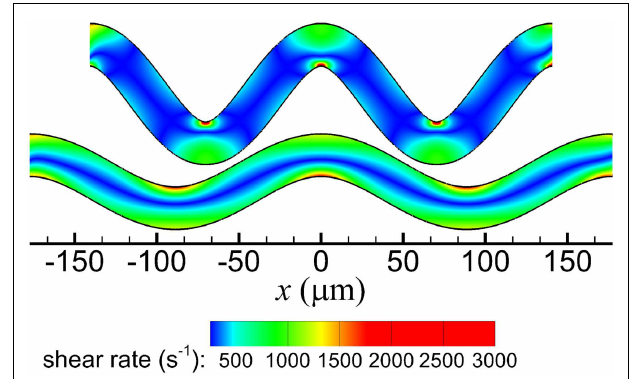
FIGURE 2 | Shear rate contours of the high tortuosity arteriole (top) and low tortuosity arteriole (bottom) .